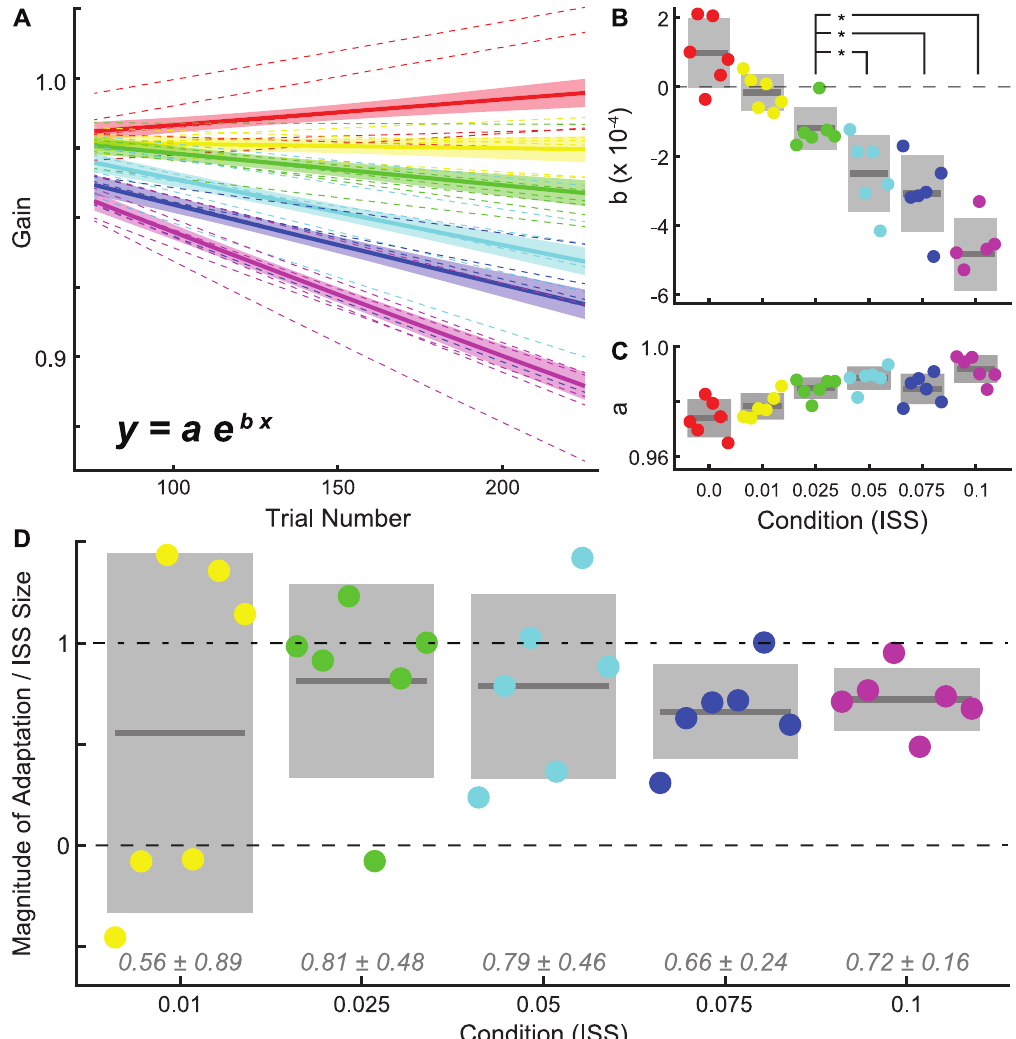
Figure 3. Rate of adaptation and ISS proportion learned. A. Single exponential fits to adapt-phase gains (y) as a function of trial number (x). We show fits to individual subject gains (dashed lines) as well as to gains pooled by condition (solid lines; shaded areas are 95% prediction bounds). To fit pooled data, we first additively aligned individual subject gains: setting each subject’s final 50 baseline trials to a mean across subjects. Individual conditions are colored as in B, C, and D. B. Fit rate parameter (‘‘b’’) estimates by condition (ISS). Colored dots are individual subjects, dark line segments and grey boxes are across-subject means and 95% CIs; dashed black line indicates a rate of 0. The small scale of these parameter values reflects the choice of gain and trial number as units for fitting. Asterisks indicate significant differences across subjects in ANOVA post-hoc tests at a =0.05. C. Estimates of scale parameter (‘‘a’’) by condition; conventions as in B. D. Magnitude of adaptation expressed as a proportion of the ISS used. Colored dots again represent individual subjects while dark line segments and grey boxes means and standard errors. Dashed and dashed-dotted black lines indicate proportions of 0 and 1, respectively. Grey italic text above axis indicate mean proportion of adaptation 6 95% CI across subjects.